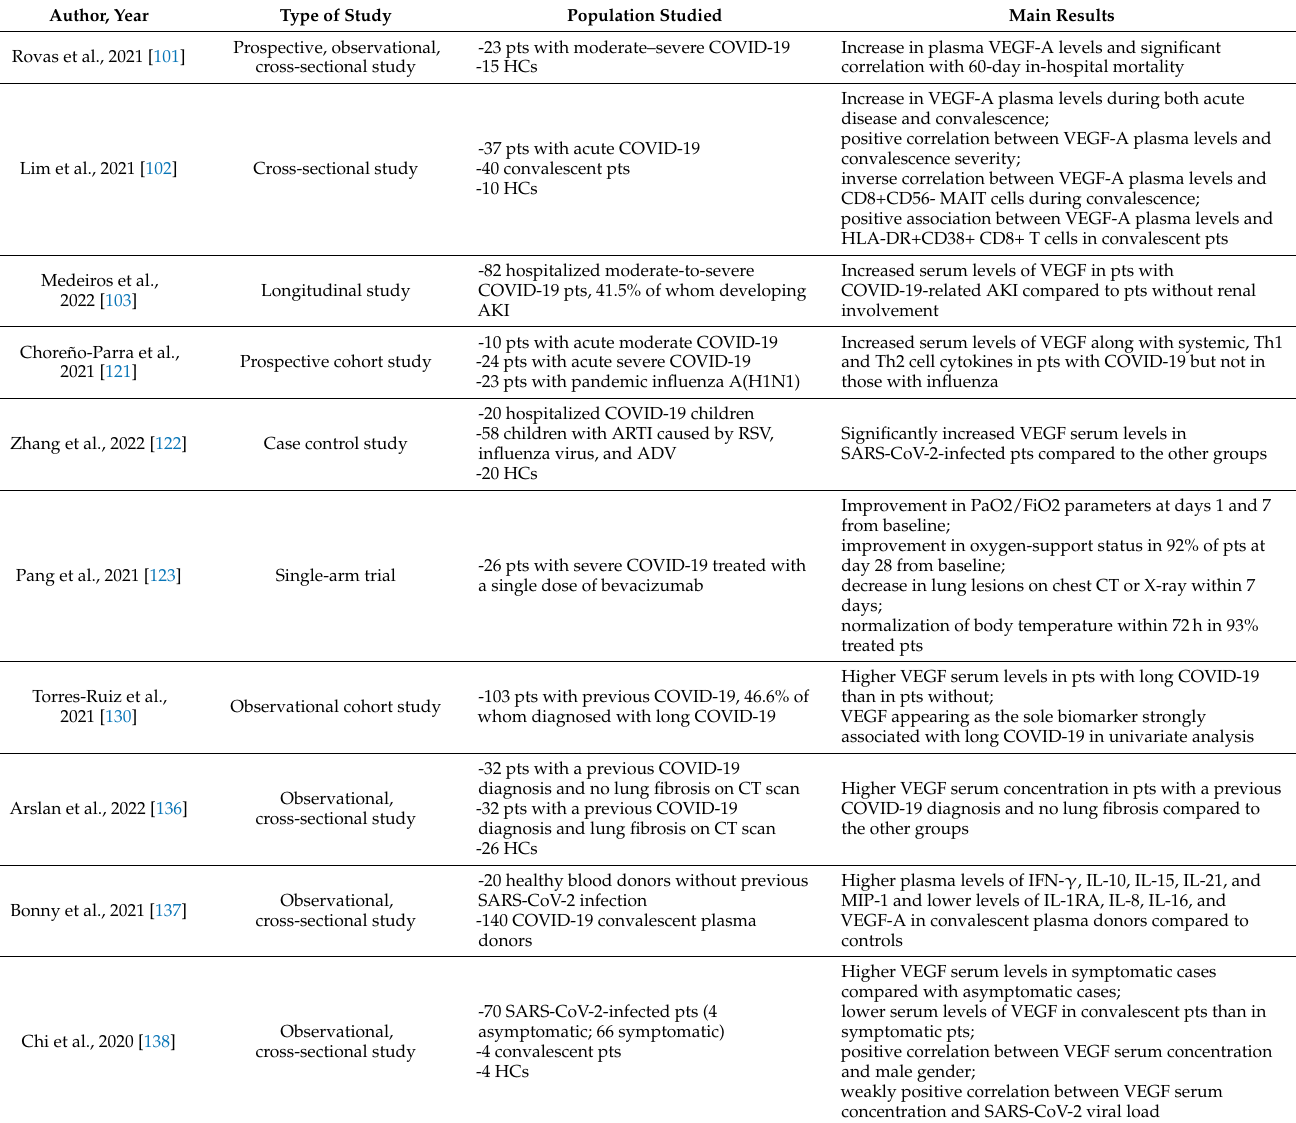
Table 3. Summary of the studies reporting altered VEGF-A expression in acute and long COVID- 19/convalescent patients or suggesting the efficacy of anti-VEGF-A interventions in acute